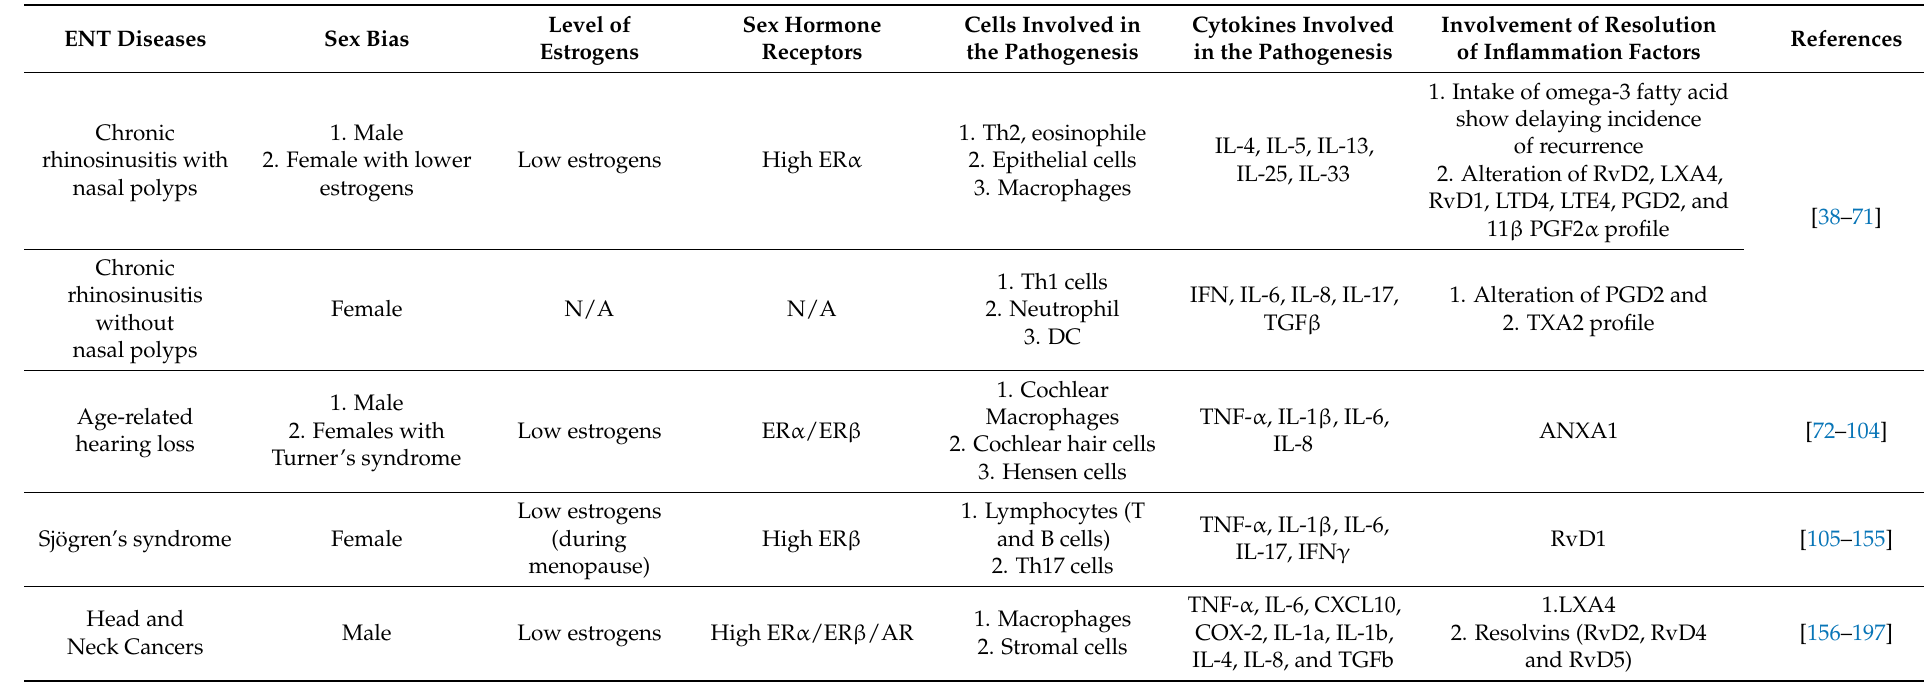
Table 1. Sex difference in ENT diseases from the perspectives of inflammatory responses and specialized proresolving mediator-driven